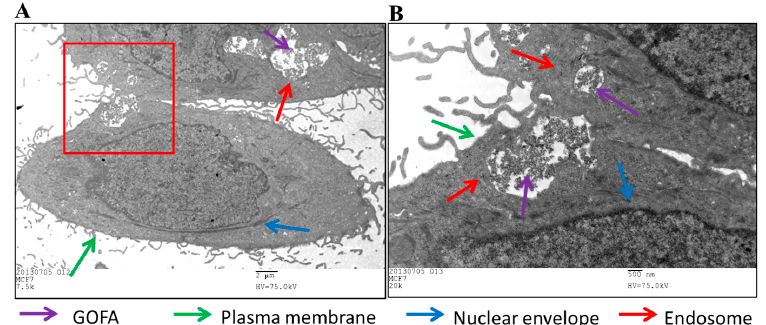
Figure 6. ( A ) Transmission electron microscope (TEM) micrographs of MCF-7 cells treated with GOFA for 1 h. ( B ) is an enlarged view of the square in ( A ). ( A ) Bar = 2 μ m, ( B ) Bar = 500 nm.